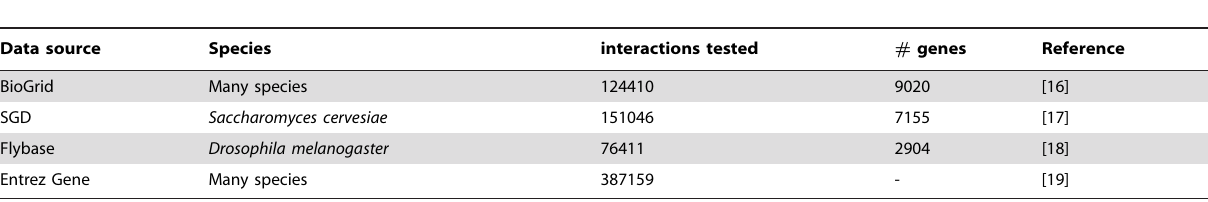
Table 1. Sources of genetic interaction